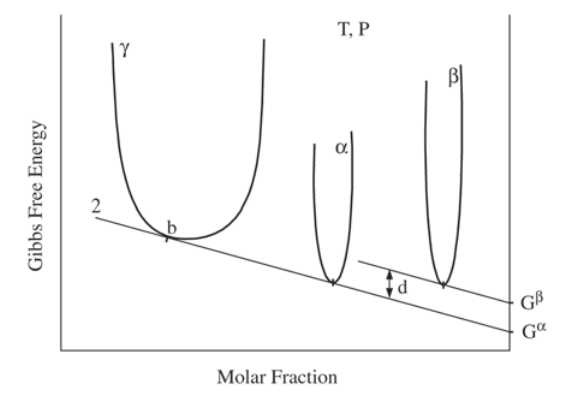
Figure 2. Schematic representation of the driving forces of the thermodynamical stability.